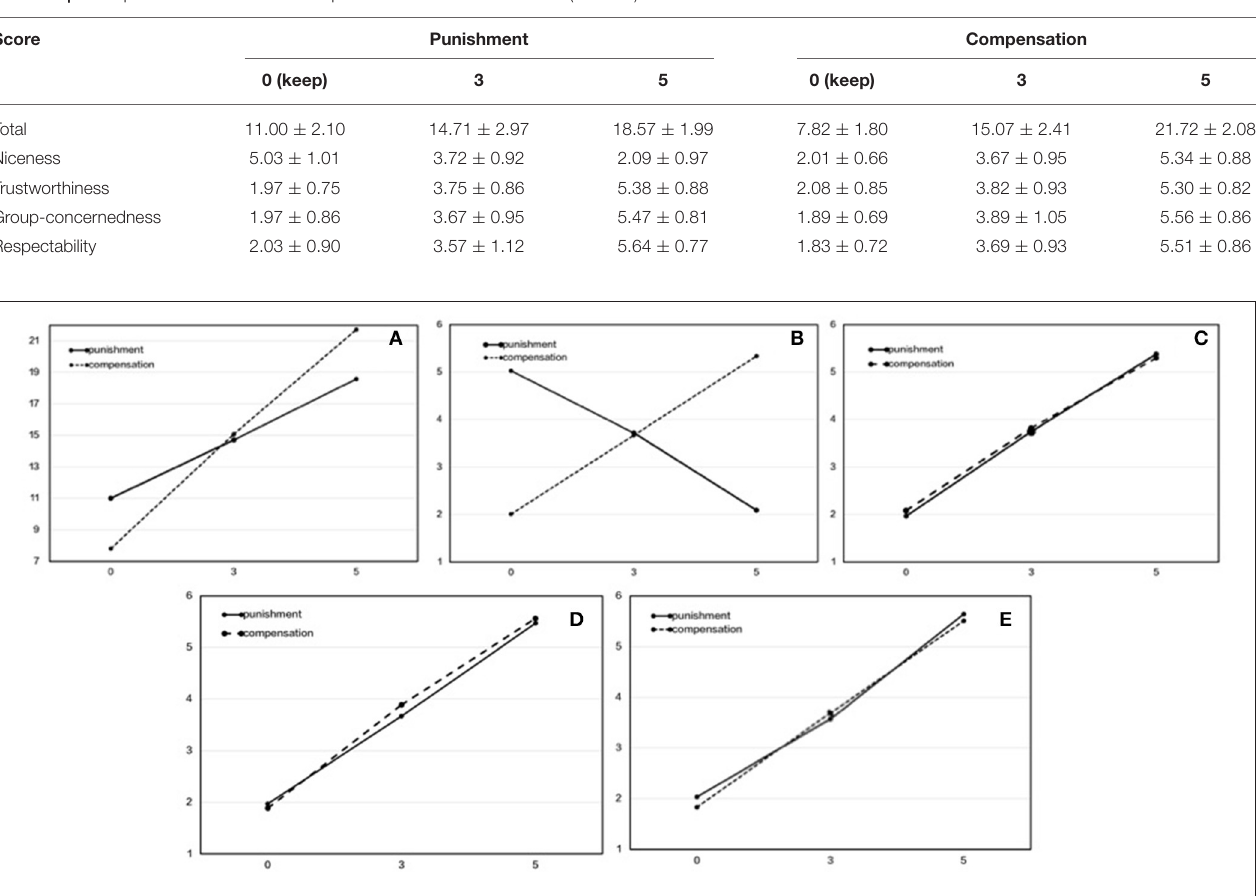
FIGURE 1 | The difference in reputation between punishment and compensation when third parties were not free to choose. The horizontal axis is the transfer amount, and the longitudinal axis is the reputational score. (A) Total score. (B) Niceness. (C) Trustworthiness. (D) Group-concernedness. (E) Respectability.